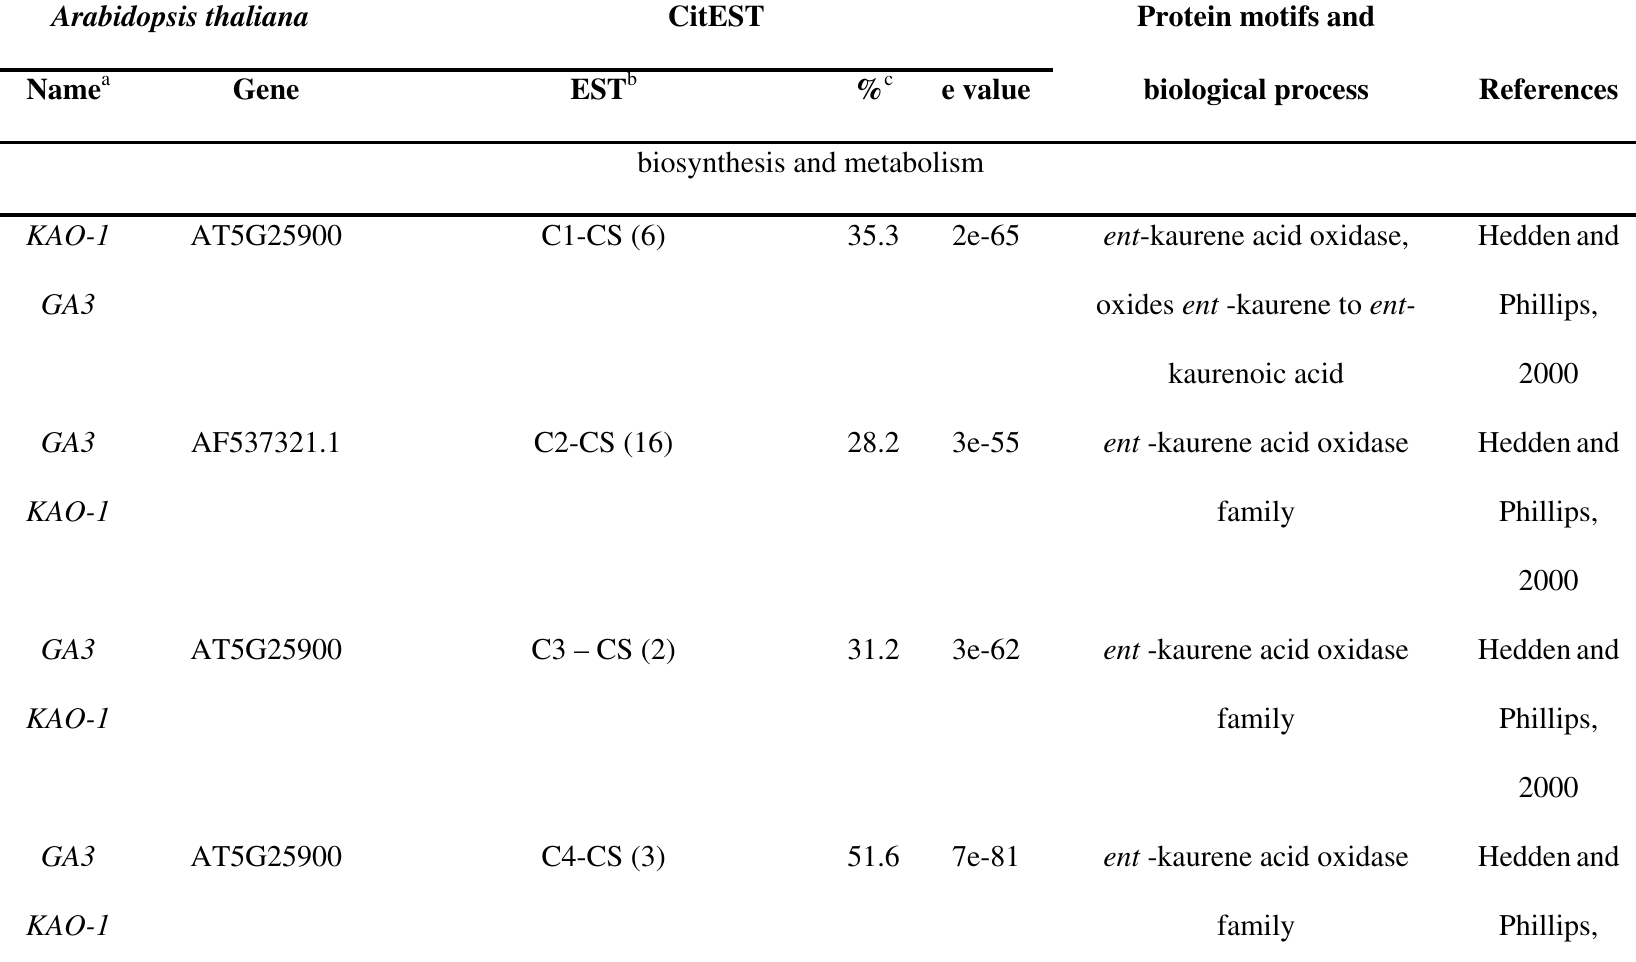
Table S10 – Citrus ESTs with homology to genes involved in gibberellic acid biosynthesis, metabolism and signal transduction in Arabidopsis thaliana